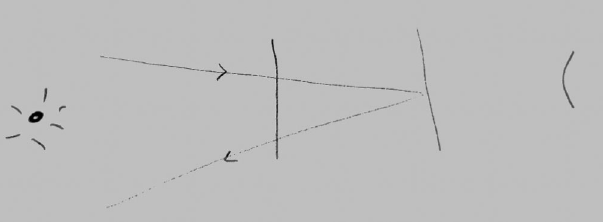
FIG. 6. Drawing that student S16_G made to visualize the polarization of light as the reflection of light off the second polarizer.